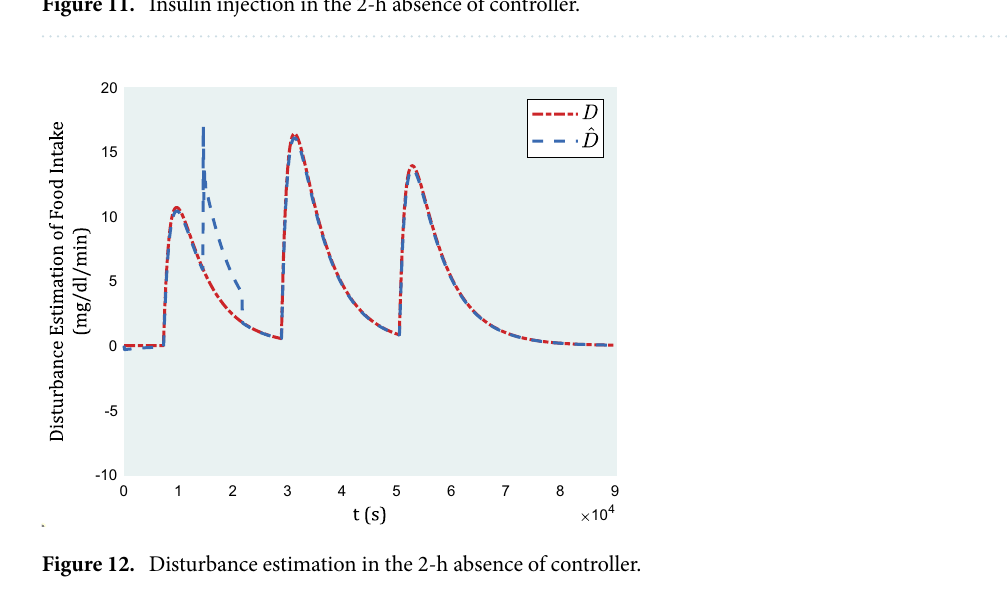
Figure 11. Insulin injection in the 2-h absence of controller.